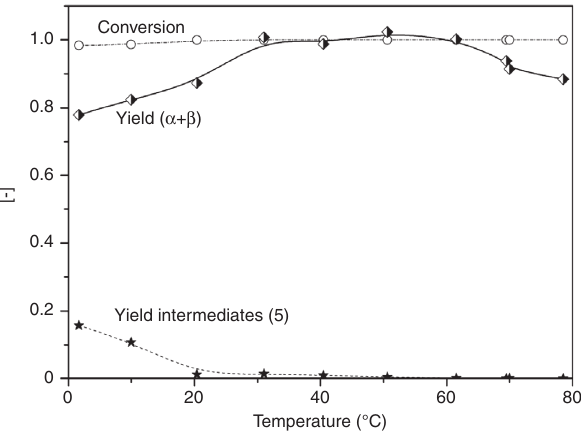
Figure 13 Yield and conversion at the outlet of the multi-injection reactor during cyclization of pseudoionone as function of coolant temperature. Thereby α and β denote α -ionone and β -ionone, and intermediates (5) are two isomers of 6,10-dimethylundeca-3,5-di- one-10-hydroxy-2-one. Total flow rate: 3 ml/min (0.18 m/s), initial = 1.25 m; c = 7.5 concentrations: c PI H 2 SO 4